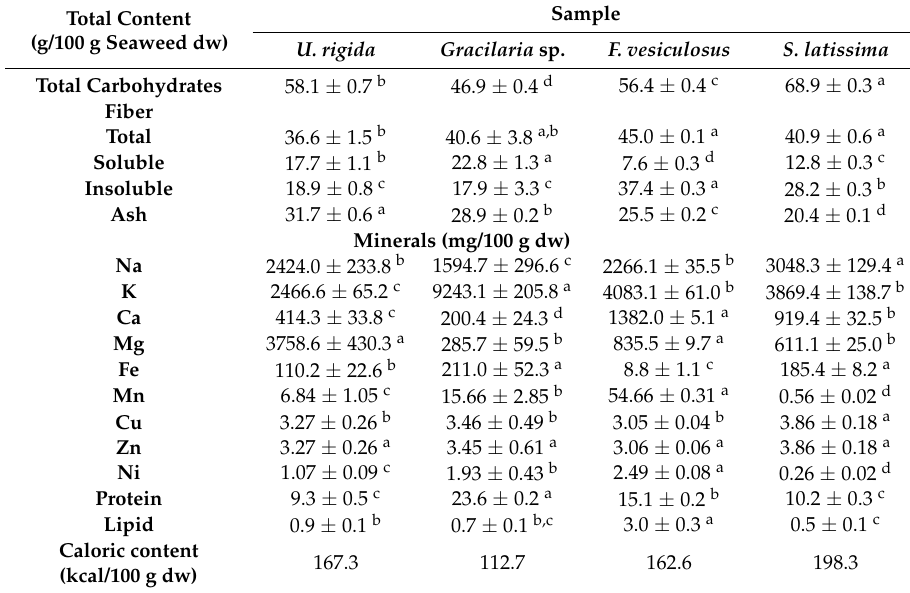
Table 1. Nutritional value of the four